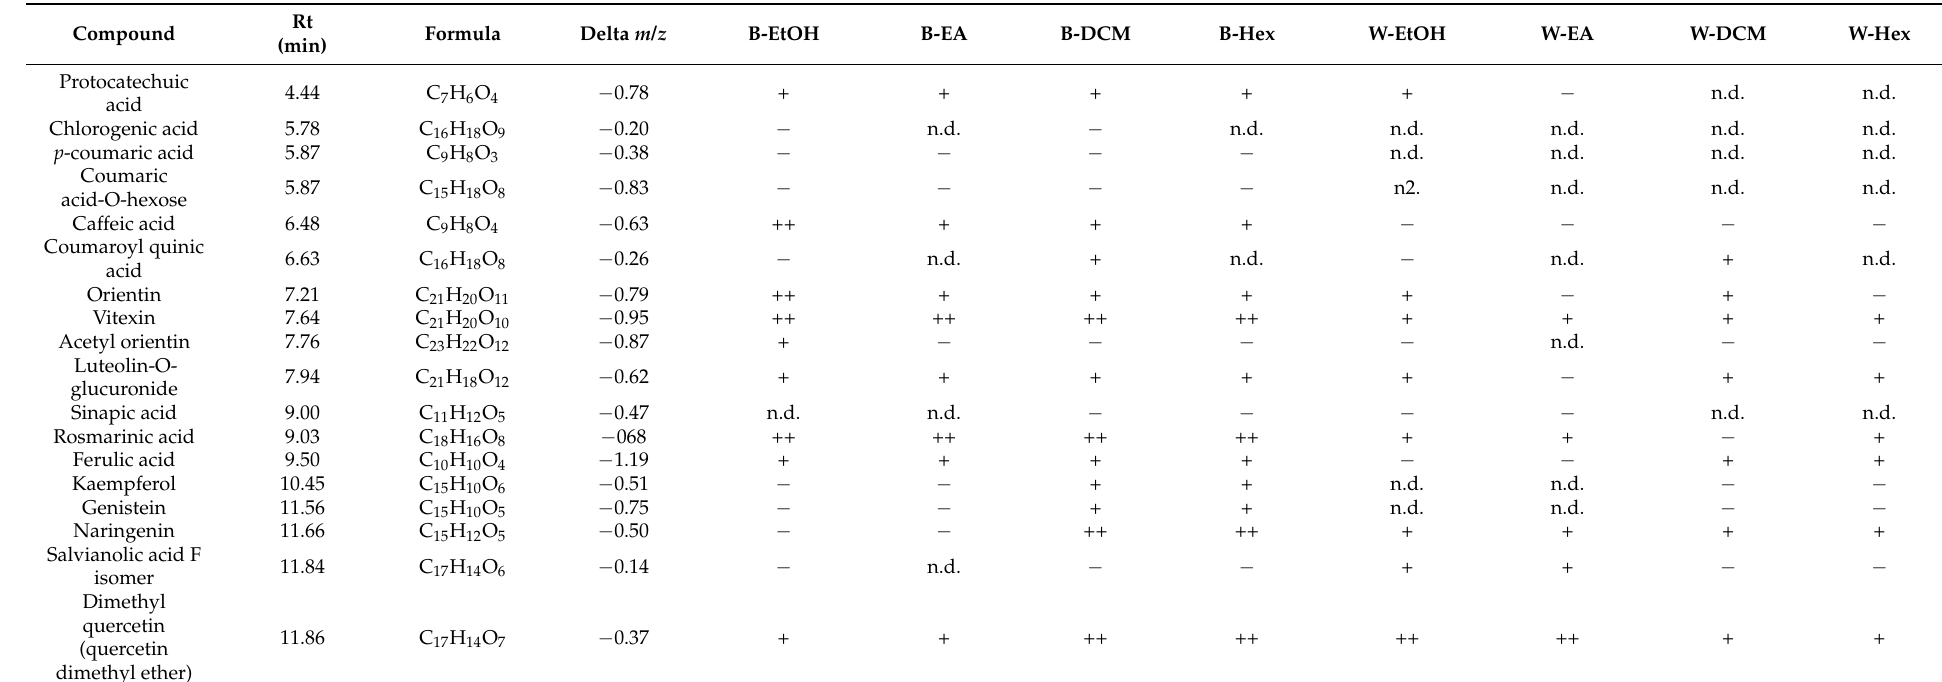
Table 2. Tentative identification of bioactive compounds in chia leaf extracts of black (B) and white (W) seed